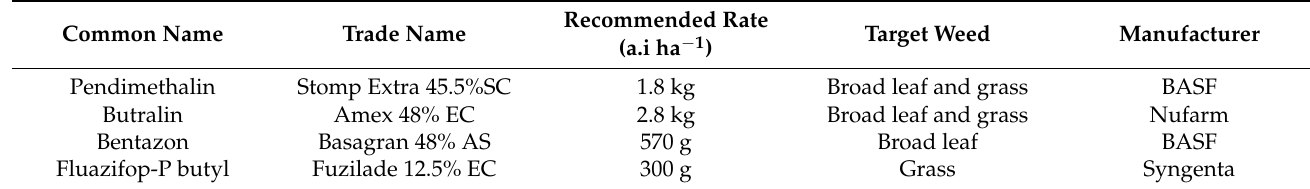
Table 1. Characteristics of the herbicides used in the